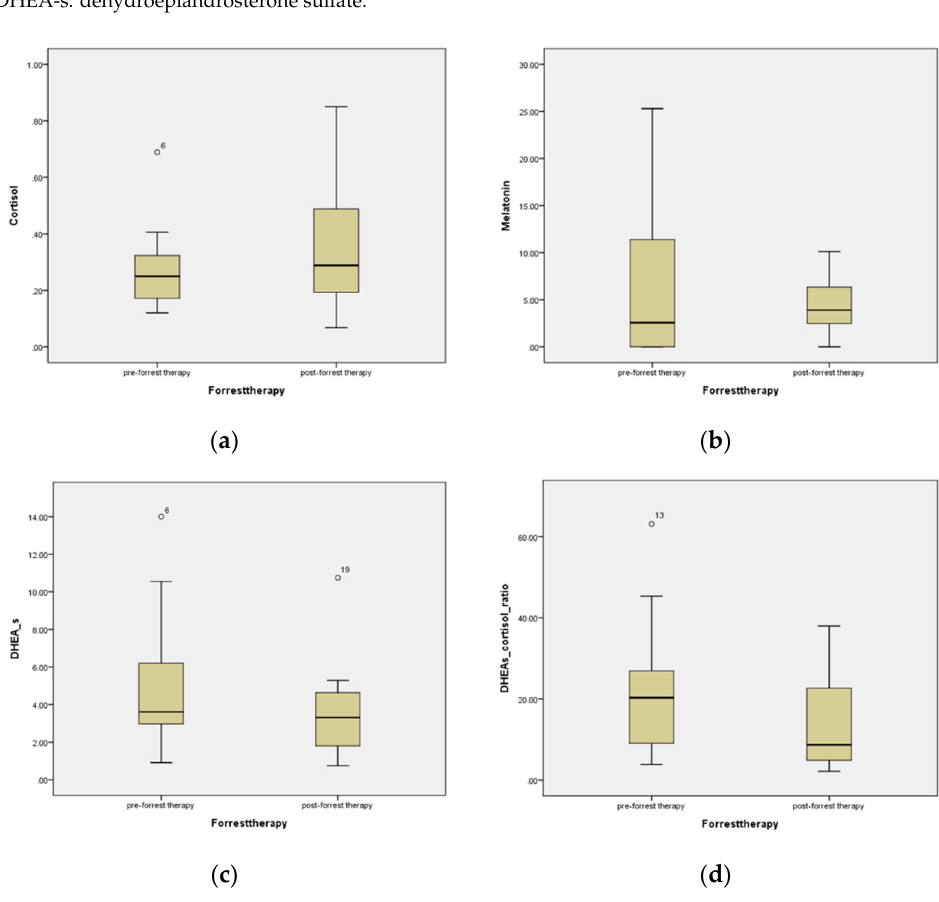
Figure 2. Changes in the level of ( a ) cortisol, ( b ) melatonin, ( c ) DHEA-S, and ( d ) DHEA-s/Cortisol ratio in participants before and after forest therapy. ratio in participants before and after forest